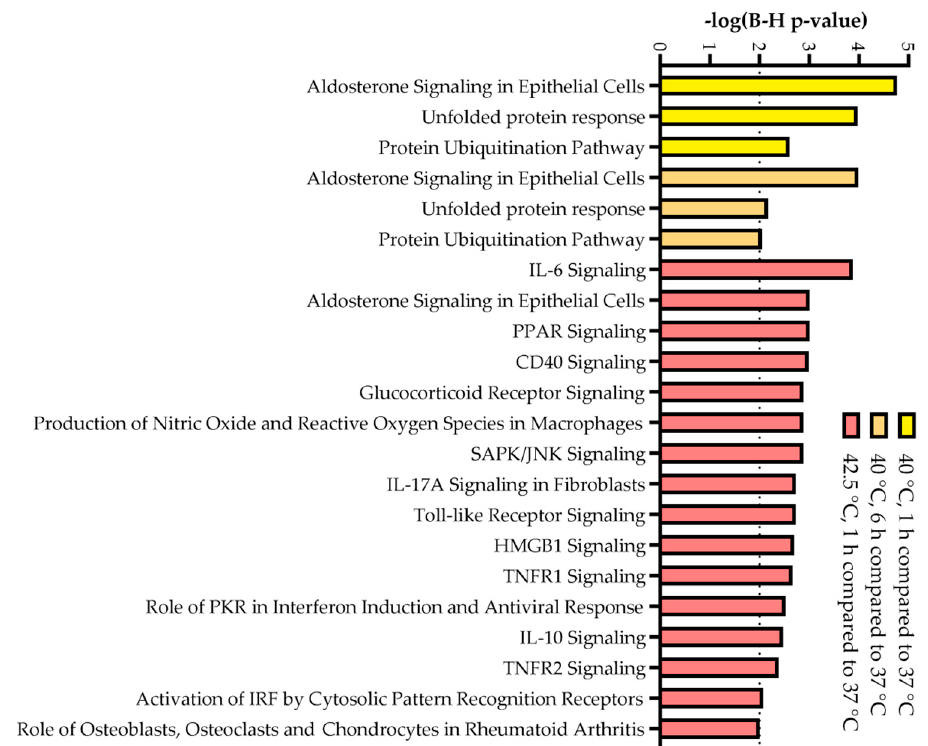
Figure 5. The most significantly enriched canonical pathways ( − log(B-H p -value) > 2.0) in heat- treated CHO cells derived from Ingenuity Pathway Analysis (IPA).